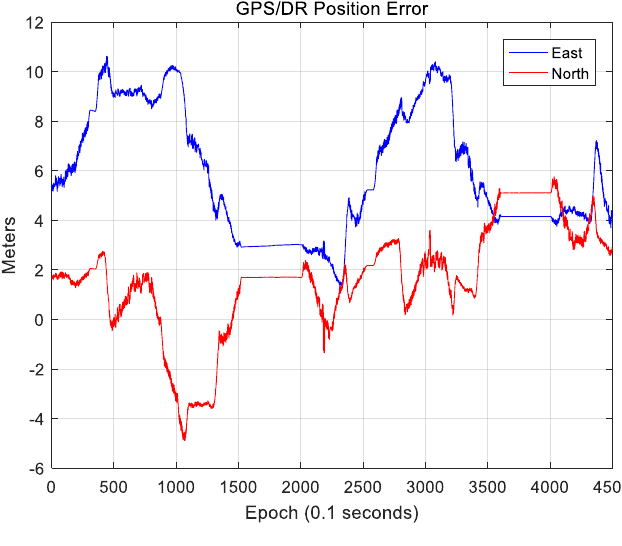
Figure 23. Position error of GPS/DR.